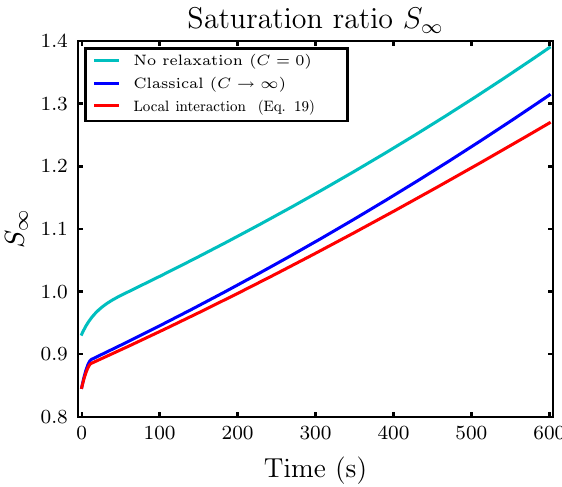
Figure 10. Temporal evolution of saturation ratio S ∞ with respect to water for the same simulation as in the upper row of Fig. 9 with ambient saturation ratio S ∞ = 0 .